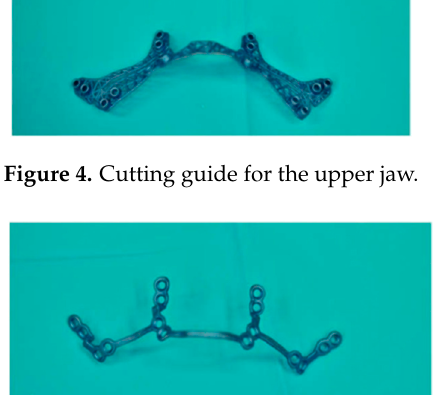
Figure 3. 3D maxillary and mandibular models in the final position: ( a ) front view; ( b ) bottom view; ( c ) right-side view; ( d ) left-side view. Figure 4. Cutting guide for the upper jaw.